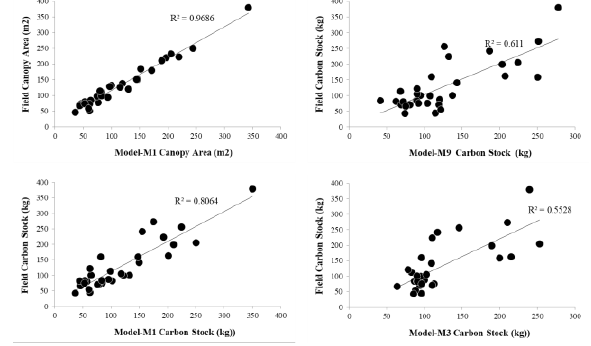
Figure 7. The relationship among field estimated and modelled above-ground biomass and carbon stock of top-three models for each plot size as 30x30m. For model details see Table 4 and Table 5. Table 4 shows the evaluation of biomass prediction from Pleiades-1 and Sentinel-2 derived vegetation cover area and Sentinel-1 SAR and Sentinel-2-derived band combination and vegetation index of observed and predicted values as well as the prediction error. Model-M1 was best modelled when a combination of vegetation coverage area was used as Pleiades-1 and Sentinel-2 derived vegetation cover data. For model-M9, the results were comparable to model-M1 but with lower R 2 (Fig. 7). Finally, model-M1 was determined as the optimal model for estimation above-ground biomass using vegetation index to extract coverage. This model was expressed as AGB=- 0.231+2.111*Cov and the detailed evaluation coefficients were shown in Table 4. Based on the selected optimal model as model-M1 linear regression analysis, the carbon stock of the study area was estimated and compared with field estimated carbon stock in Fig 8 and Table 5, the distribution was mapped as shown in Fig. 9. In this figure, the light grey marks area with no shrub, which is covered by bare land. The light green areas indicate the carbon stock lower than 20 kg/100m 2 while the blue areas indicate a value higher than 40 kg/100m 2